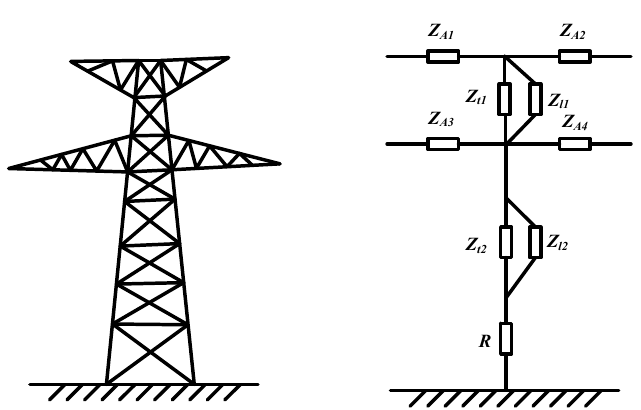
Figure 1. The diagram of multi-surge impedance model.